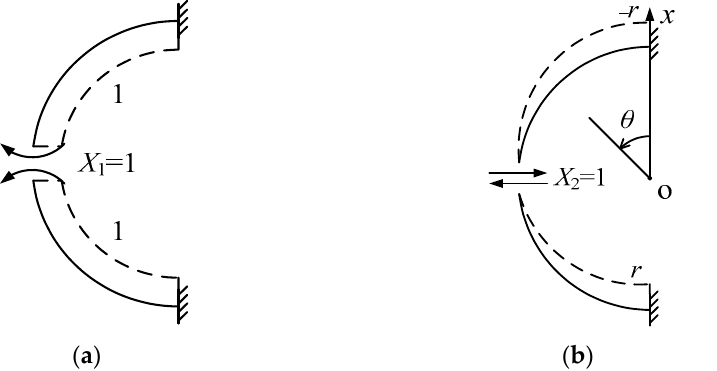
Figure 3. Bending moment diagram under unit force. ( a ) M 1 diagram ( M 1 = 1). ( b ) M 2 diagram ( M 2 = − r · cos θ